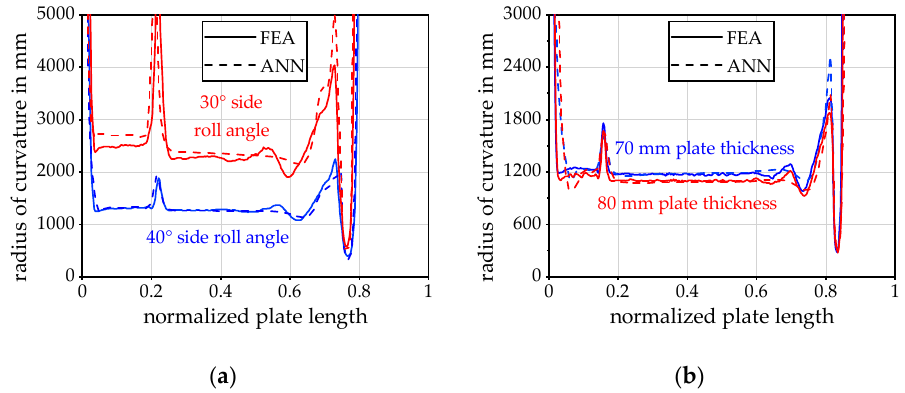
Figure 7. Investigation of the prediction capability of the ANN for variation of ( a ) the side roll angle and ( b ) the plate thickness.